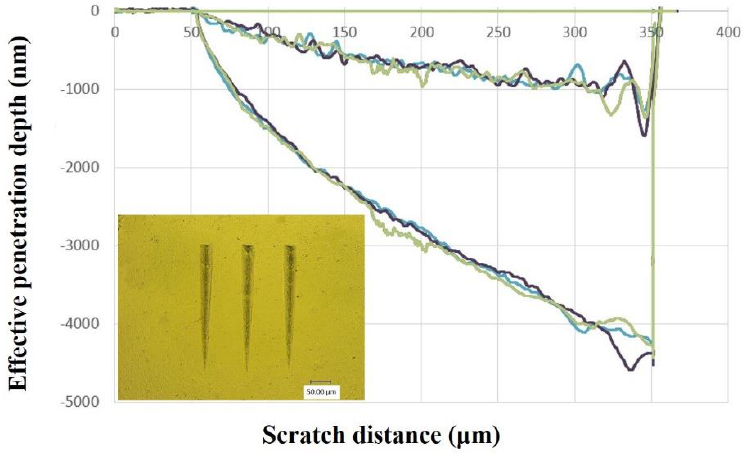
Figure 4. The e ff ective penetration depth curves of neat dental resin matrix under Figure 4. The effective penetration depth curves of neat dental resin matrix under load.